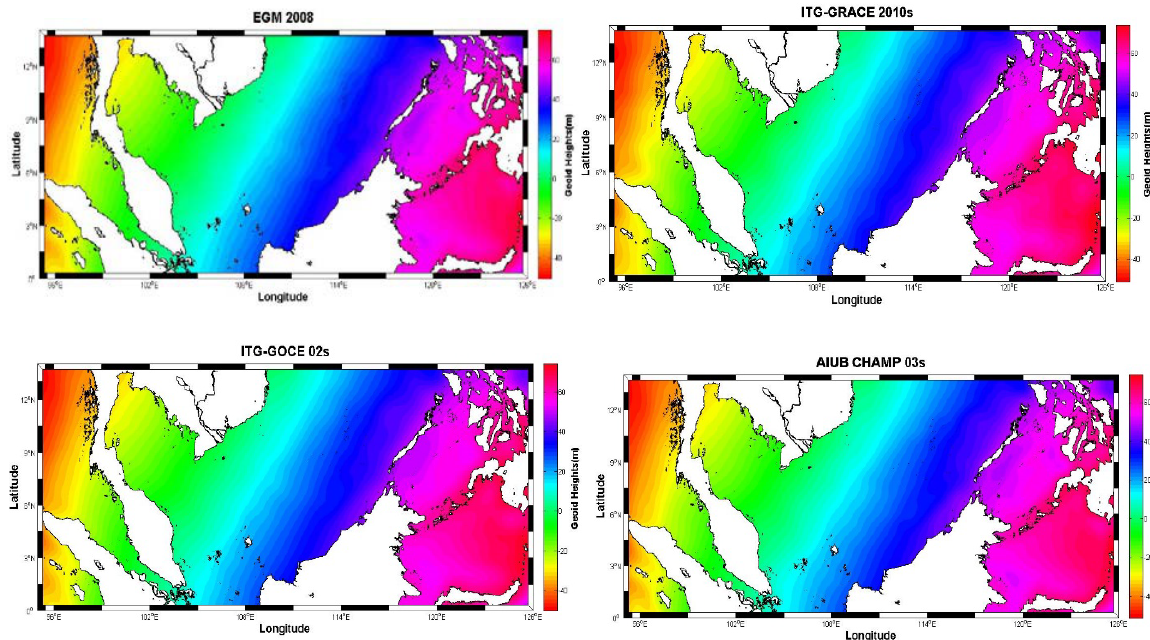
Figure 5. The geoid undulations from GGM (EGM 2008, ITG-GRACE 2010s, ITG-GOCE 02s and AIUB CHAMP